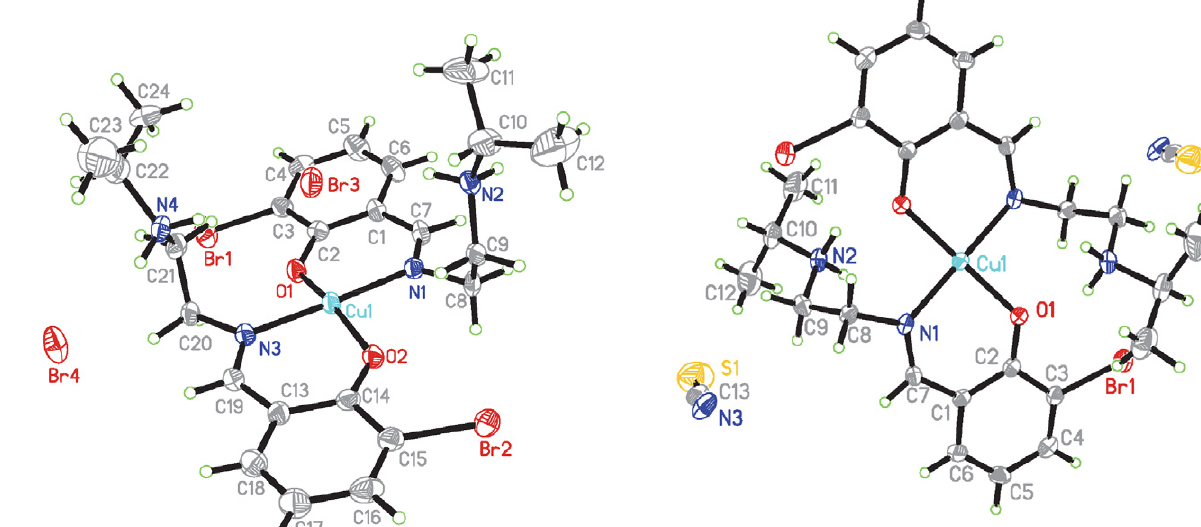
Figure 2. A perspective view of complex 2 with the atom labeling scheme. Thermal ellipsoids are drawn at the 30% probability level. The unlabeled atoms are related to the symmetry operation 1 – x , – y , – z